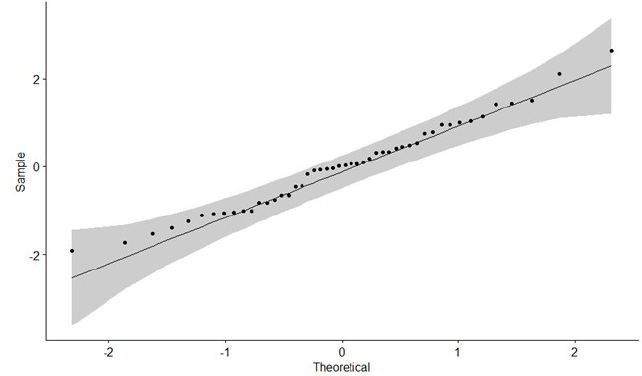
Figure 16. The normal probability plot of the control chart for deficiency 01.